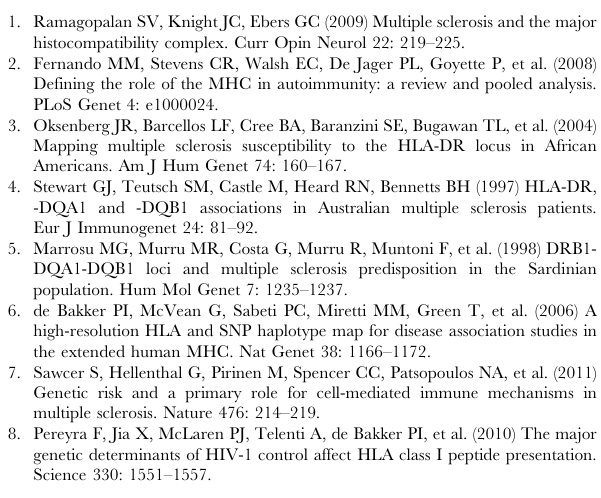
Figure S4 Analysis of amino acid residues in DR b 1. The univariate analysis results are in the first row. Each next one plots the 2 log10(p-value) of the amino acid positions conditioning on the amino acid residues if the previous rows. The solid black line marks the threshold of statistical significance in the study. The rows represent univariate analysis (A), conditioning on position 71 (B), conditioning on the above and position 74 (C), conditioning on the above and position 57 (D), conditioning on the above and position 86 (E). Table S1 Statistically independent effects of the DRB1 locus considering four digit resolution alleles. In all cells Odds Ratios are listed. P-values are listed in parentheses for the forward stepwise regression. The order of the DRB1 alleles is according to the forward stepwise regression (primary analysis). The stopping rule was the residual DRB1 locus effect to have a p-value . 1.0e 2 05 . * For the regression-based methods the step number in which the allele was included in the model is displayed. Effect sizes (and p-values) per variants are for the respective step in the forward stepwise regression and for the final model in the least angle and forward stagewise regressions. $ For the lasso and elastic net the Odds Ratios are displayed, since both methods provide the best solution. The largest value of l 1 regularization parameter such that error is within 1 standard error of the minimum l 1 regularization parameter was used to identify the best solution. Both the lasso and elastic net also identified *01:01 in their best solution, with OR of 0.99 and 0.97, respectively. This allele comes up in step 7 in all regression methods. Table S2 Proof of statistical independence of rs2516489 and HLA-DRB1*15:01. The interaction term of the two variants cannot explain either of the two effects. Especially in the saturated model (both variants and the interaction term) the interaction term is not statistically significant, even at the nominal level. The stratification of the samples, based on HLA-DRB1*15:01 carrier status, reveals the effect of rs2516489 in both strata. The numbers listed are the Odds Ratio (OR), followed by the p-value. In all models principal components and dummy variable for studies were used as covariates. Table S3 Cis-eQTL effects (p-value , 0.05) of the SNPs in MICB- LST1 in PBMCs of MS subjects, CD4 + T cells of healthy individuals and CD14 + monocytes of healthy individuals. This table is included